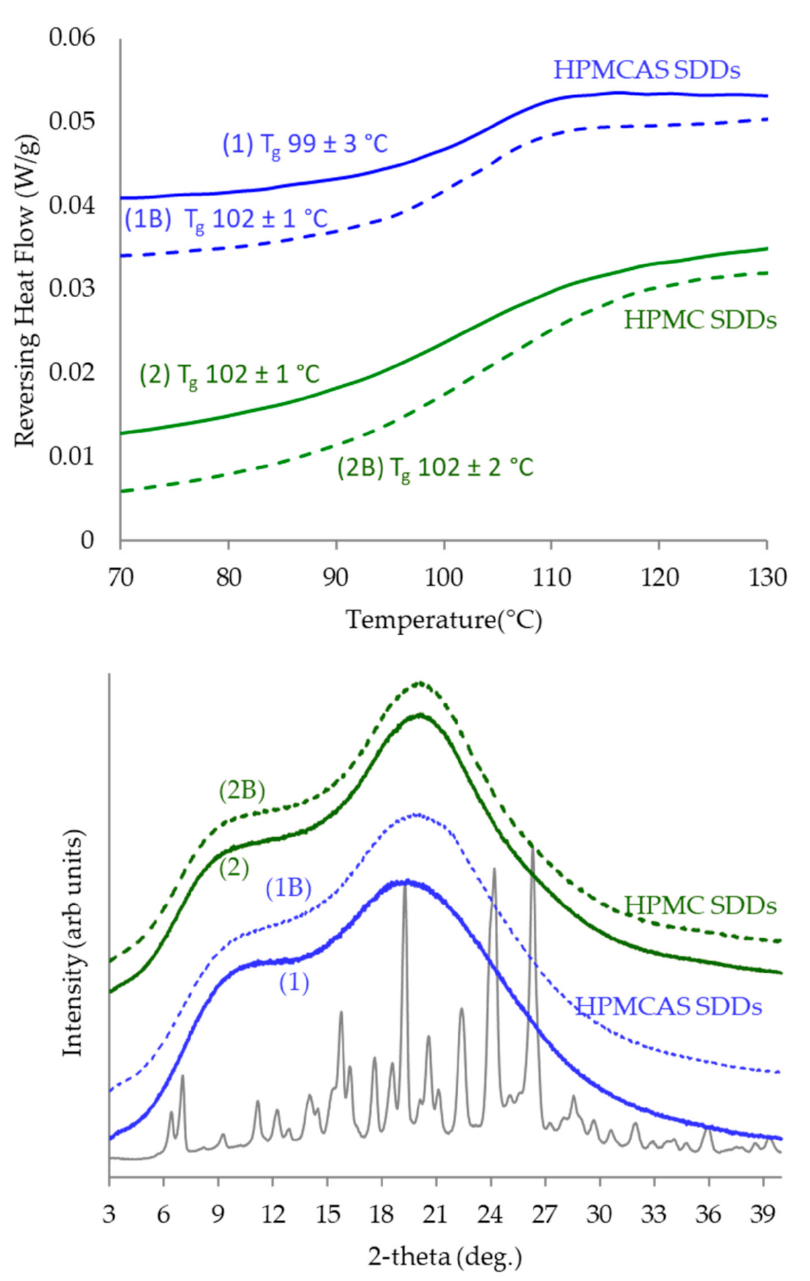
Figure 5. PXRD diffractograms ( bottom ) and DSC reversing heat flow ( top ) of the HPMC (green) and HPMCAS (blue) GEF SDDs sprayed with acetic acid compared to the controls (dashed lines). Y -axis is offset for clarity. The crystalline API lot used to manufacture the SDDs is shown for reference in the PXRD plot. DSC non-reversing and total heat flow for SDDs are shown in Figure